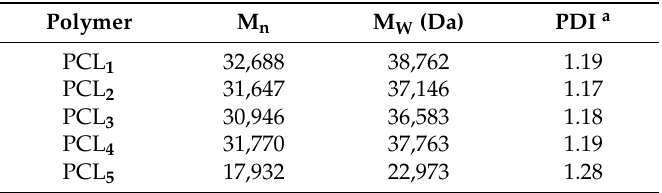
Table 5. Molecular weight distributions and polydispersity index (PDI) of the obtained polymers.